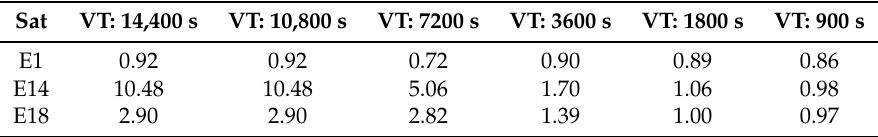
Table 4. SISE orbit RMS (m) in DOYs with higher errors (DOYs 61–65, 71, and 175–178) calculated at different validity time thresholds.